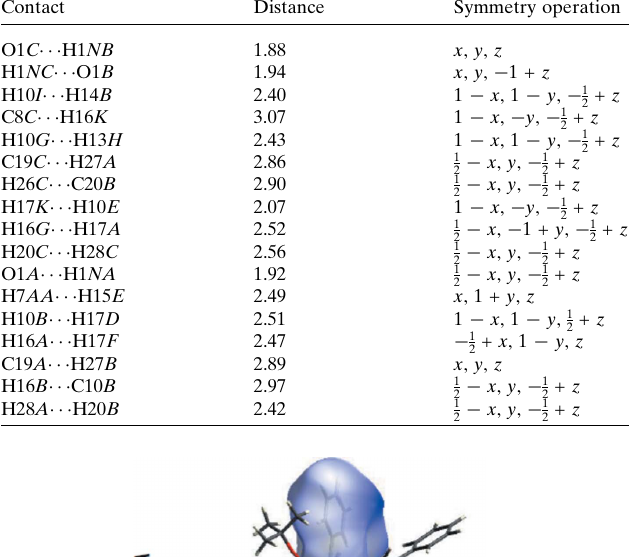
Table 3 Percentage contributions of interatomic contacts to the Hirshfeld surfaces for the molecules A , B and C of the title